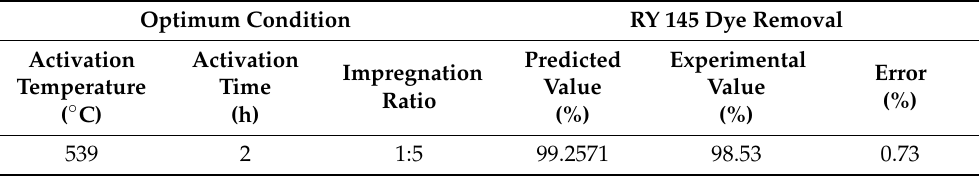
Table 7. Experimental confirmation of model predicted dye removal by the optimal